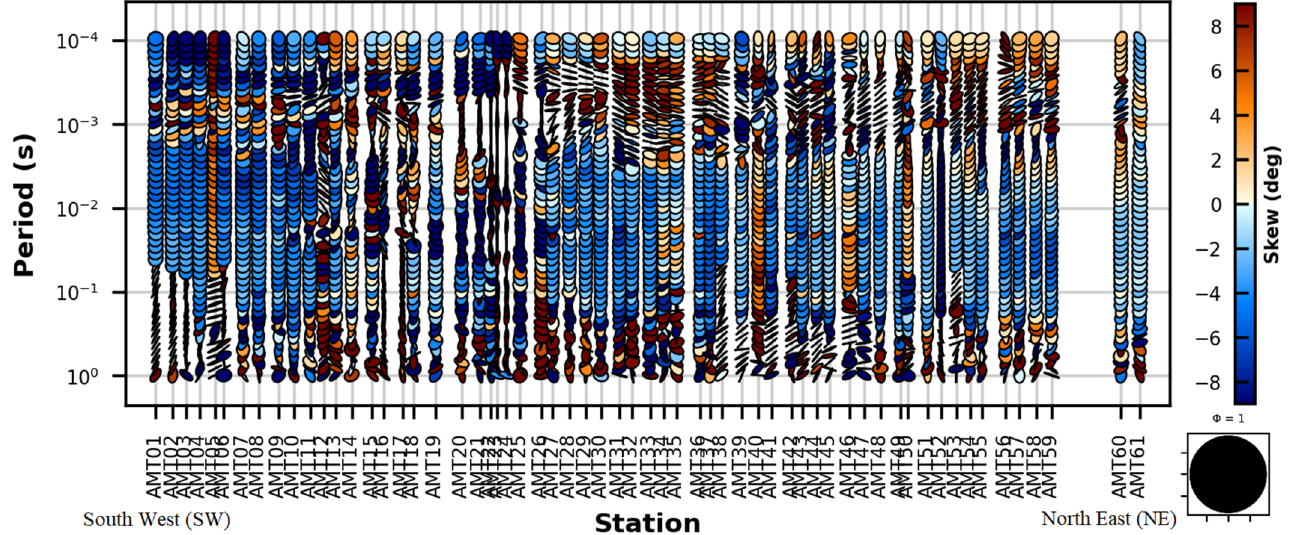
Figure 7. Phase tensor ellipses pseudo ‐ section, color ‐ coded by skew angle values along transect SW ‐ NE. Four sites between AMT59 and AMT60 were neglected due the presence of cliffs.